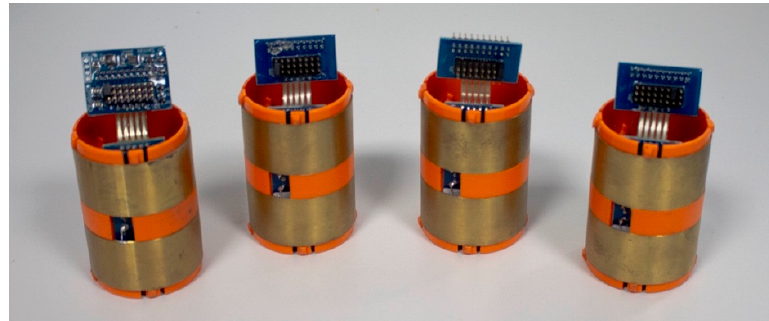
Figure 6. The electromagnetic sensors.